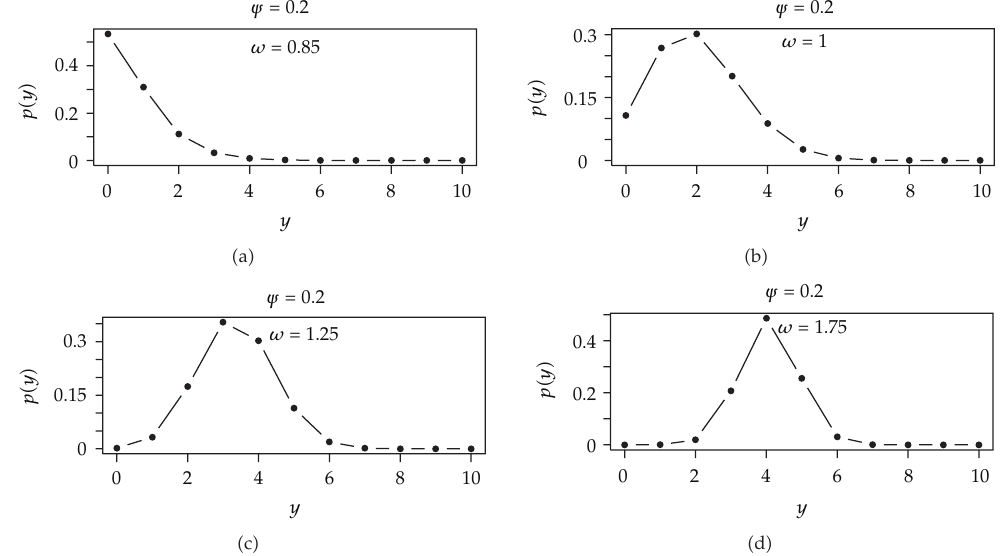
Figure 1: The distribution of Y n for di ff erent values of ω , ψ (cid:5) 0 . 2, and n (cid:5) 10. ψ = 0.5 ω = 0.750.15